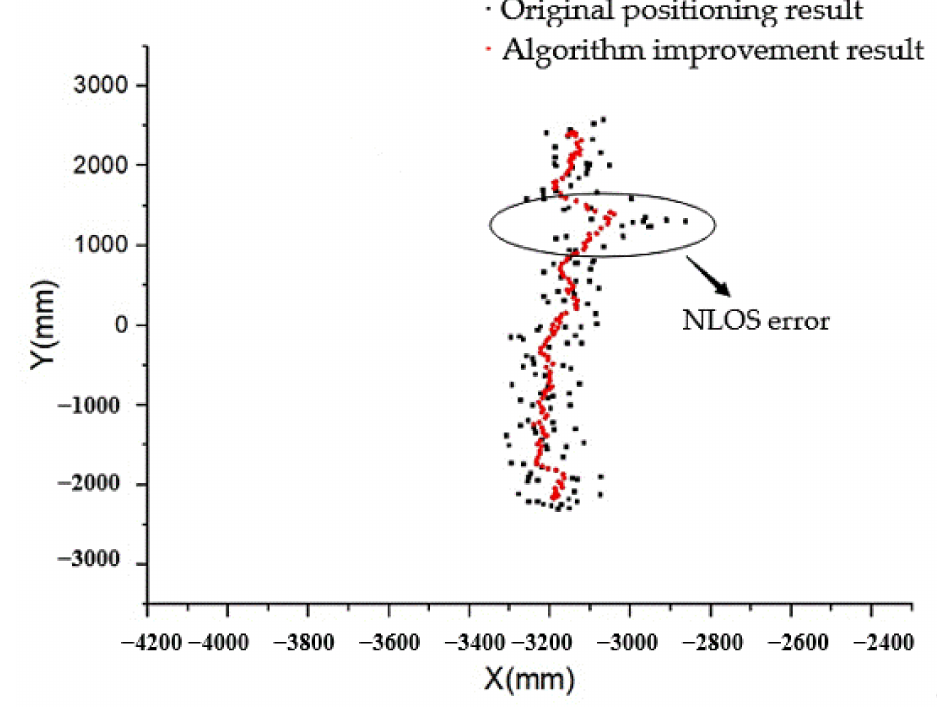
Figure 9. Positioning results of traditional